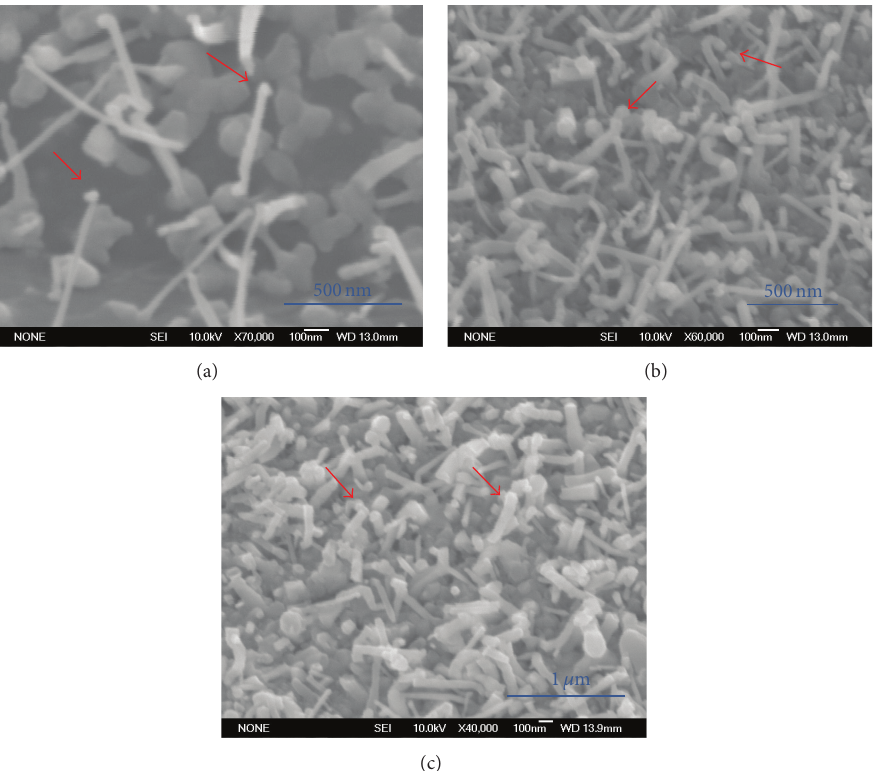
Figure 1: SEM images of ZnO:In NWs with different indium concentrations (a) undoped, (b) 0.86%, and (c) 0.95%. The red arrows point out the